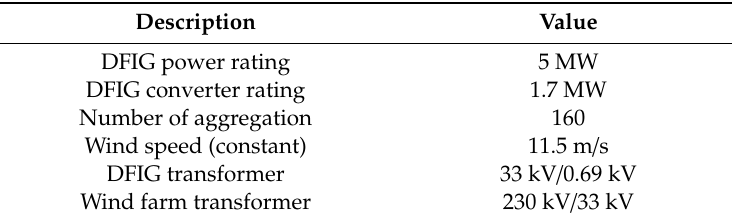
Table 1. Parameters of the simulated DFIG system.